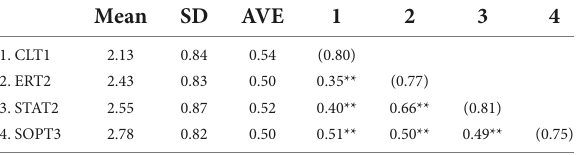
TABLE 4 Descriptive statistics, correlation, and